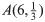
The network of the a decision game of G of 24 with options of A(6,13) (or B(6, 0.3)) and C(4, 0.5).The network can be decoupled when a decision maker takes the fix strategy. For a decision maker that chooses A (or B), the network becomes a four-stage network linking from S24 to S0 through S18, S12, and S6. For a decision maker that chooses C, the network becomes a six-stage network linking from S24 to S0 through S20, S16, S12, S8, and S4.